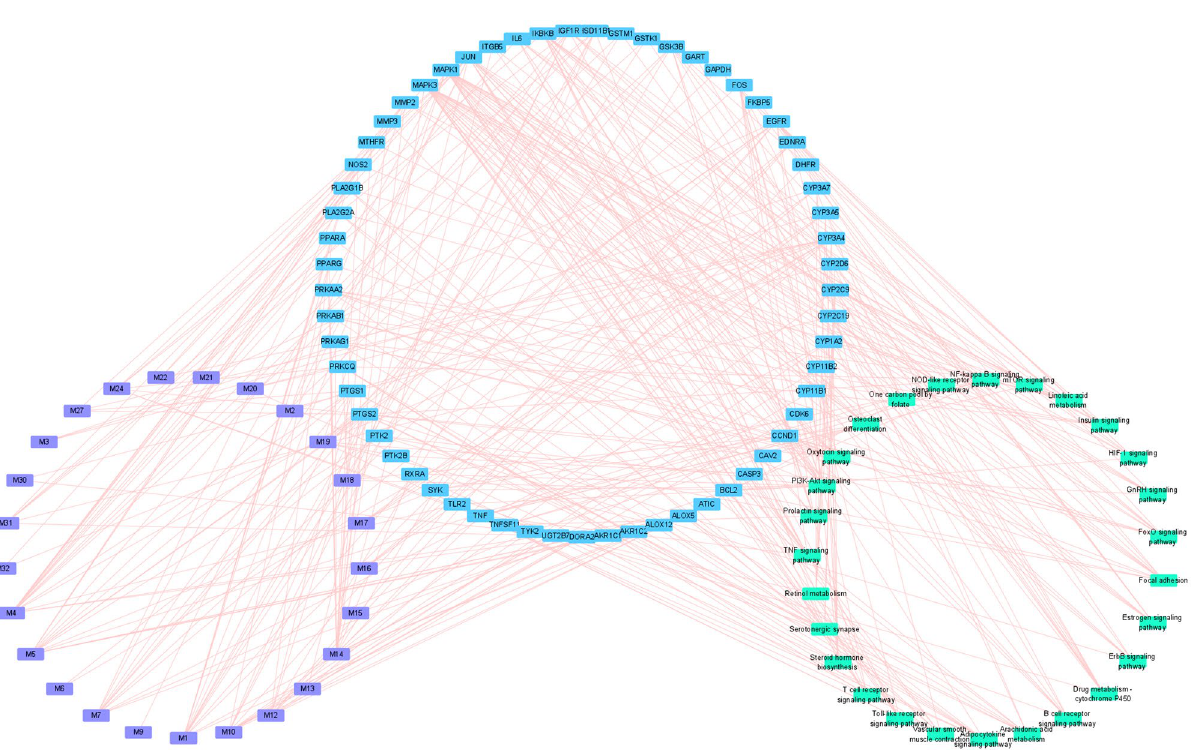
Figure 5. Compound-target-pathway network showing the comprehensive mechanism of Fuzi in treating rheumatoid arthritis. From left to right, the nodes in three big circles correspond to compounds in Fuzi, targets of Fuzi responsible for the treatment of rheumatoid arthritis, and the enriched non-disease pathways of the targets. The full name of compounds and targets are shown in Table 1 and Supplementary Table S1,